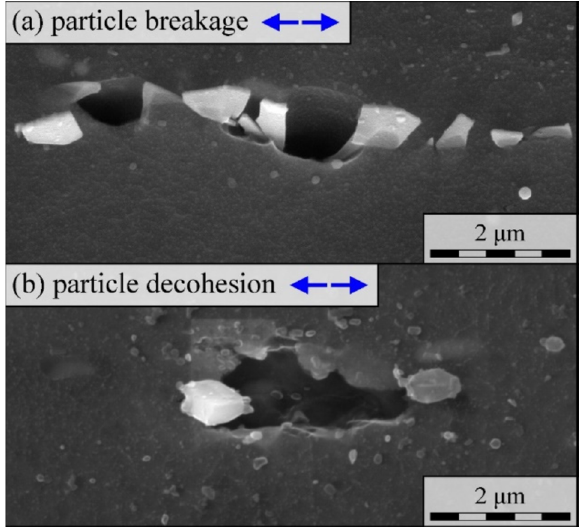
Figure 4. Two mechanisms of void nucleation in AZ31 magnesium alloy: ( a ) Particle fragmenta- tion/fracture; ( b ) Matrix–particle separation [23].